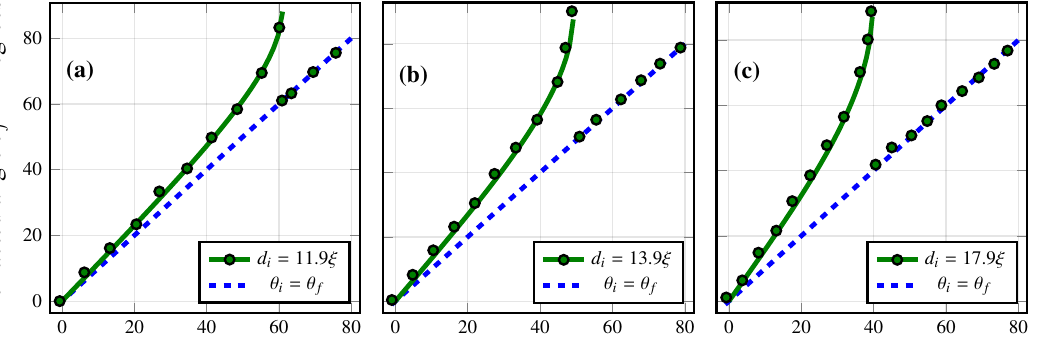
Figure 3: Incident vs refracted angles of low energy dipoles across a small, medium < ρ and large change in density ( ρ ). The initial dipole separation distance d 1 2 units of ξ . A data point on the dashed blue line represents a dipole undergoing total internal reflection, with the incident angle equal to the refracted angle. The green line is the expected result from using the formula 19a. Each subfigure shows the inci- dent vs refracted angle for the: ( a ) small step with density change ρ /ρ = 9 / 10, and ( c ) large step with density ( b ) medium step with density change ρ 1 2 /ρ = 8.5 / change ρ 1 2